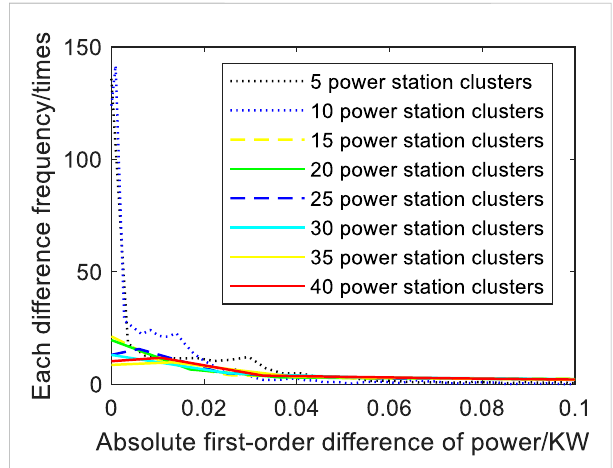
FIGURE 1 Frequency distribution of power difference absolute values of each cluster power